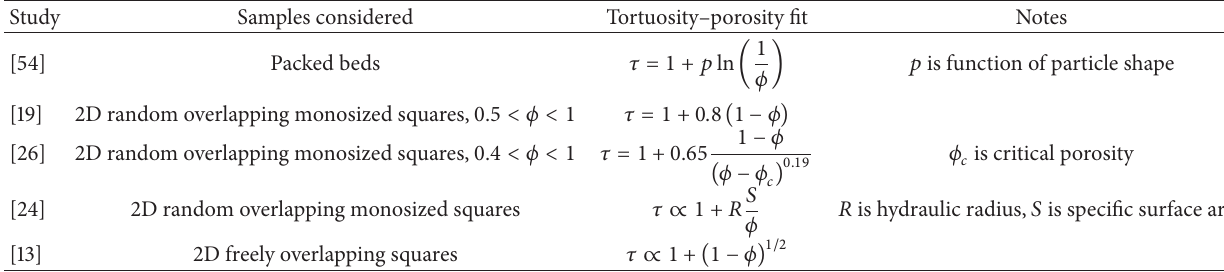
Table 2: Past work on hydraulic tortuosity.